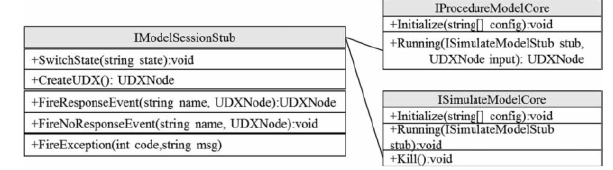
Figure 9 Model component encapsulation interfaces An object with an IModelSessionStub interface